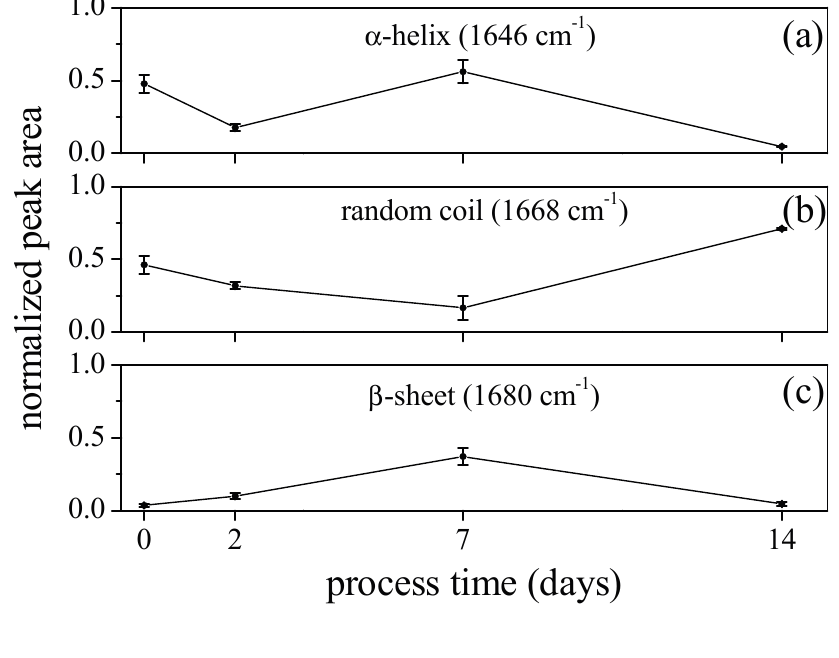
Figure 5. Peak area of subband components of PDL Raman spectrum in the Amide I region, as a function of the orthodontic treatment time, for α -helix ( a ); random coil ( b ); and β -sheet mode ( c ). The data are normalized to the Amide I mode total area.